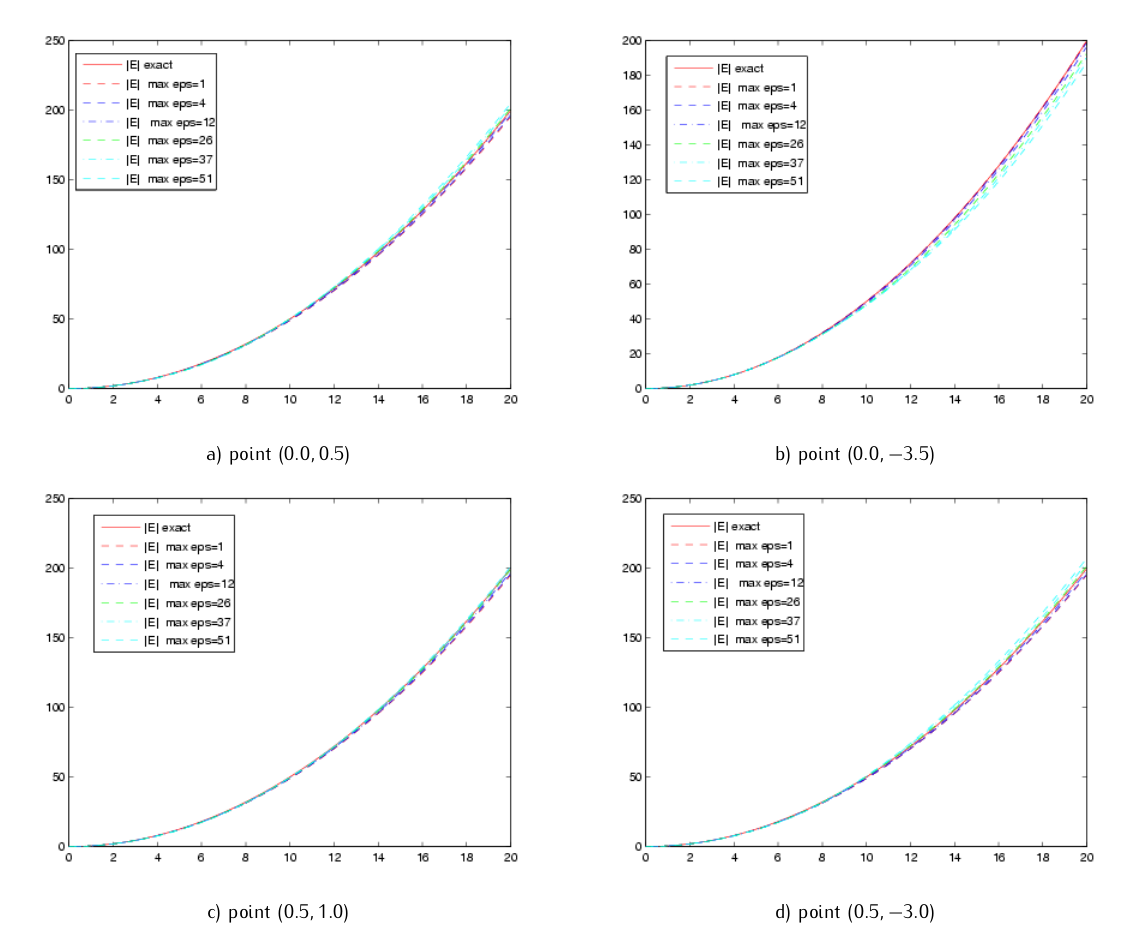
(47) solutions to equation (45) during T = (0 , 20) : a) at the point (0 . 0 , 0 . 5) , which is located ; b) at the point (0 . 0 ,− 3 . 5) , which is located at the bottom boundary of Ω FEM ; d) at the point (0 . 5 ,− 3 . 0) , which is located at the lower part of Ω FEM